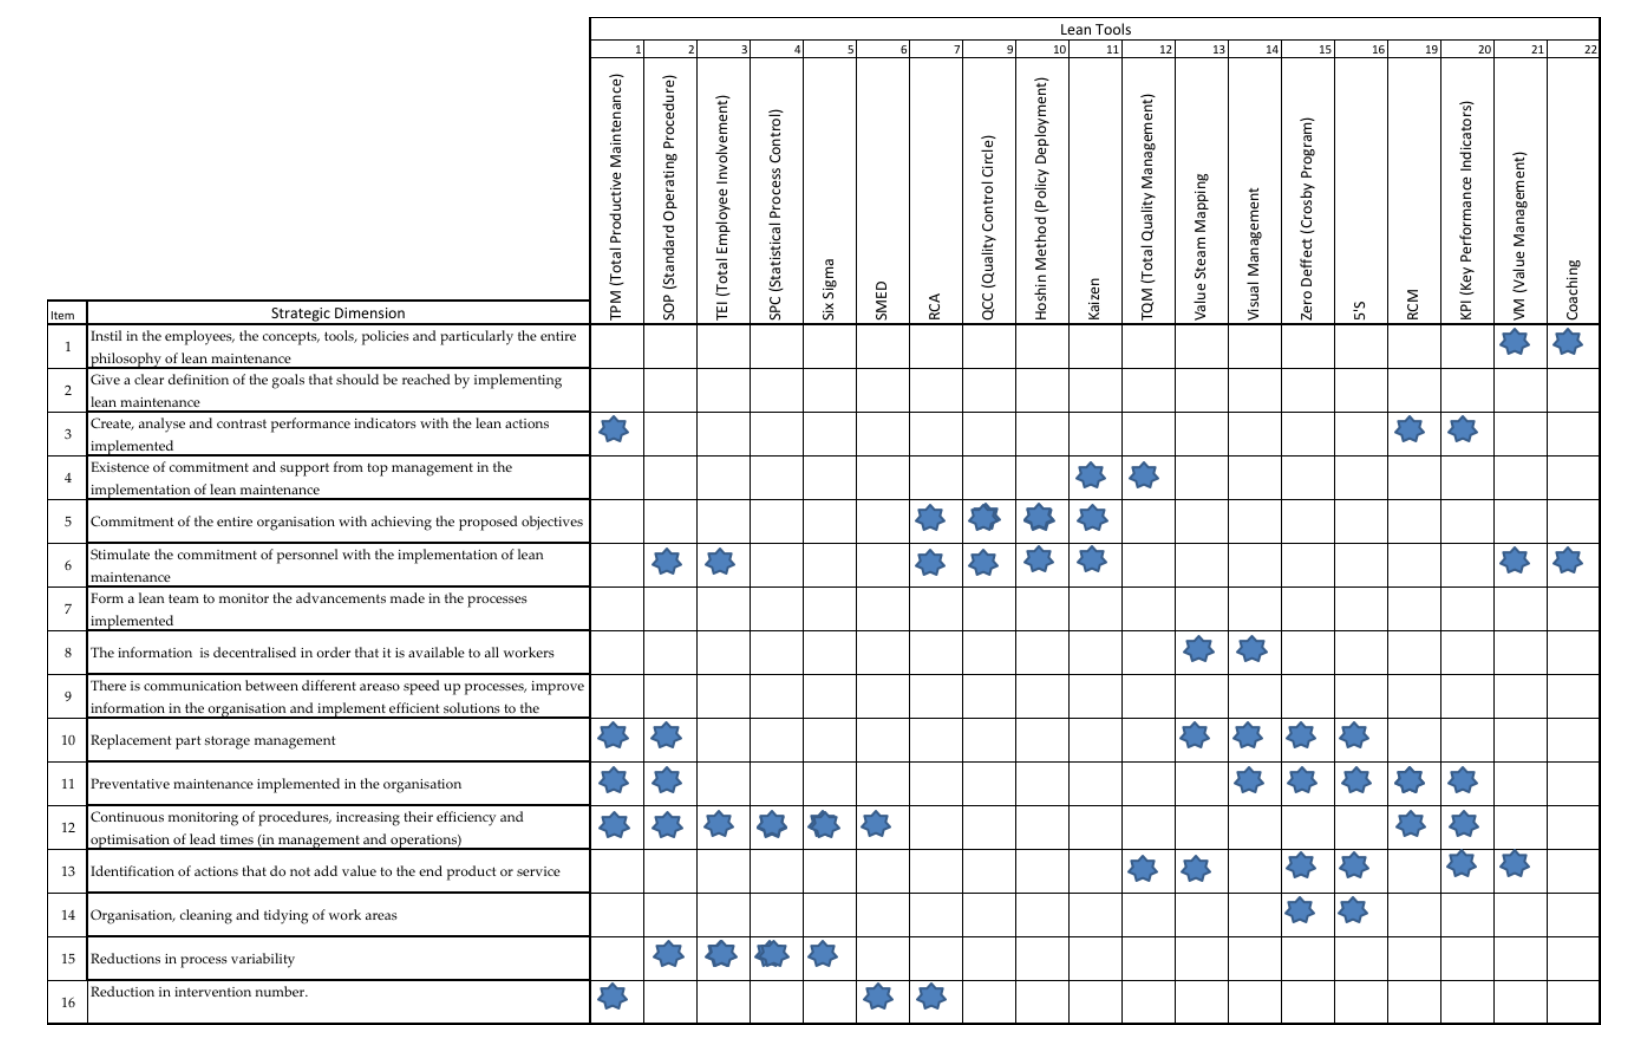
Figure 4. Decision table for linking strategic dimensions with lean tools.